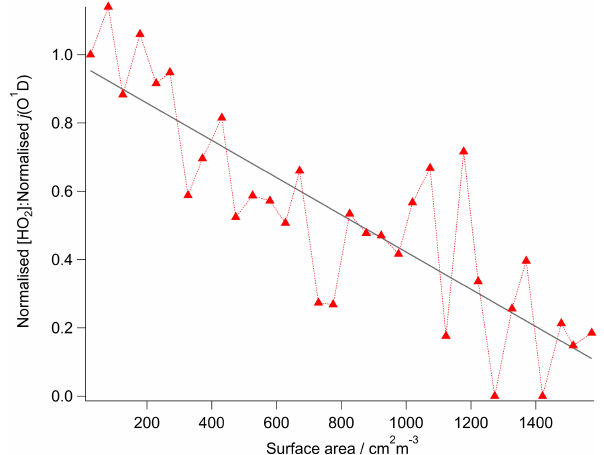
Figure 4. The dependence of the measured HO 2 concentration as a function of cloud droplet surface area. To remove the influence of changing photolysis rates, the measured HO 2 concentrations have been divided by the correspondingly observed rate of photolysis of ozone ( j (O 1 D)). This ratio has then been normalised to give a value of 1 when the droplet surface area was zero. The sys- tematic decrease in this normalised ratio with increasing droplet surface area suggests that in addition to the reduction in HO 2 caused by a reduction in the photolysis rates within clouds, there is a further loss process that increases with cloud droplet surface area. The ratio decreases linearly with increasing droplet surface area up to 1500cm 2 m − 3 , with the line of best fit being ratio =1– 5 × 10 − 4 × SA.